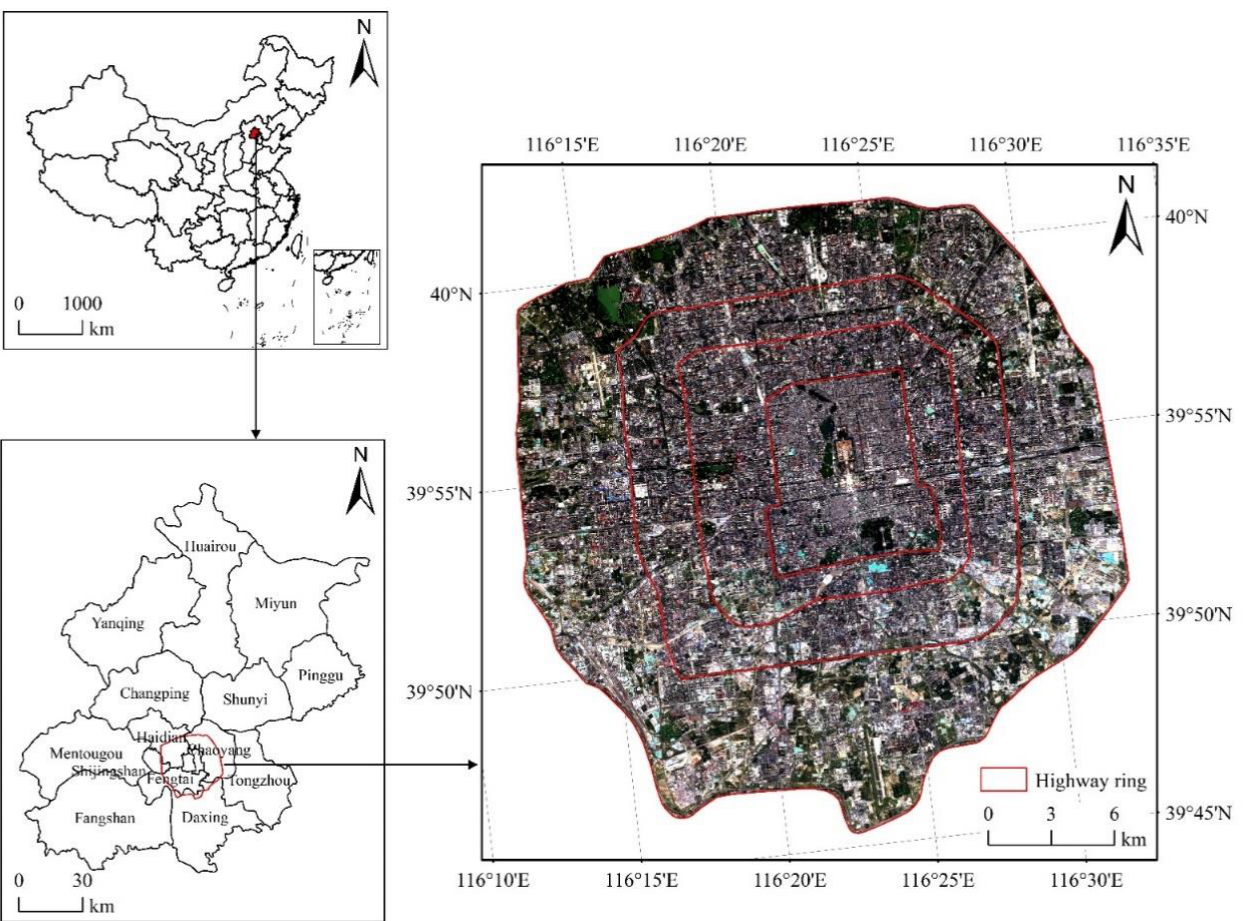
Figure 1. Location of the study area.